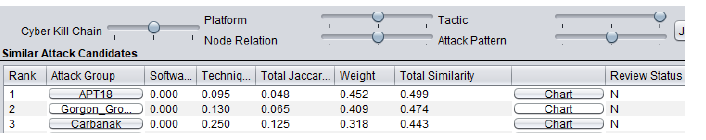
Figure 13. APT feature similarity relationship for the input scenario and each result.